Question: Condense the content of this figure into a single sentence.
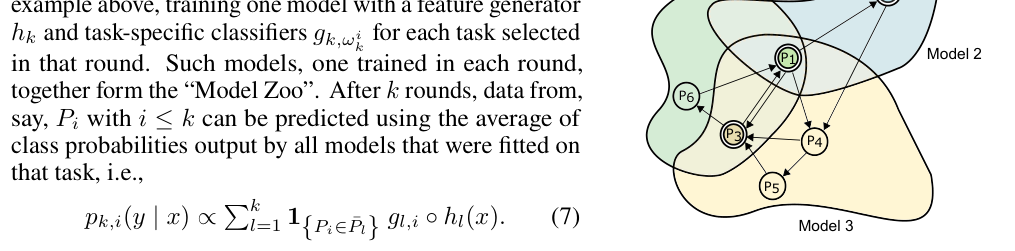
Answer: Ideally, we want to train synergis- tic tasks together, e.g., Model 1 for P1 using P3, P6 and Model 3 for P3 using P1, P4, P5. At test time, all models (1, 2, 3) that were trained on a particular task, say P1 would make predictions. Model Zoo is a simple, scalable instantiation of this idea. Discov- ering noncompeting tasks is diﬃcult, so it selects tasks that have high training loss under the current ensemble.